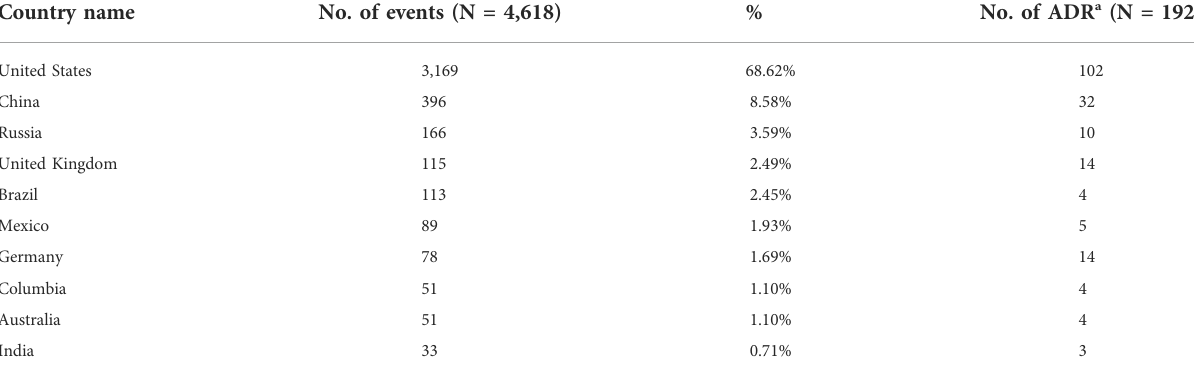
TABLE 2 Top 10 countries with counterfeit-related ADRs in the FAERS database (1982 – 2021) and presumptive ADR in the OpenVigil database (2004Q1 to 2022Q1). Country